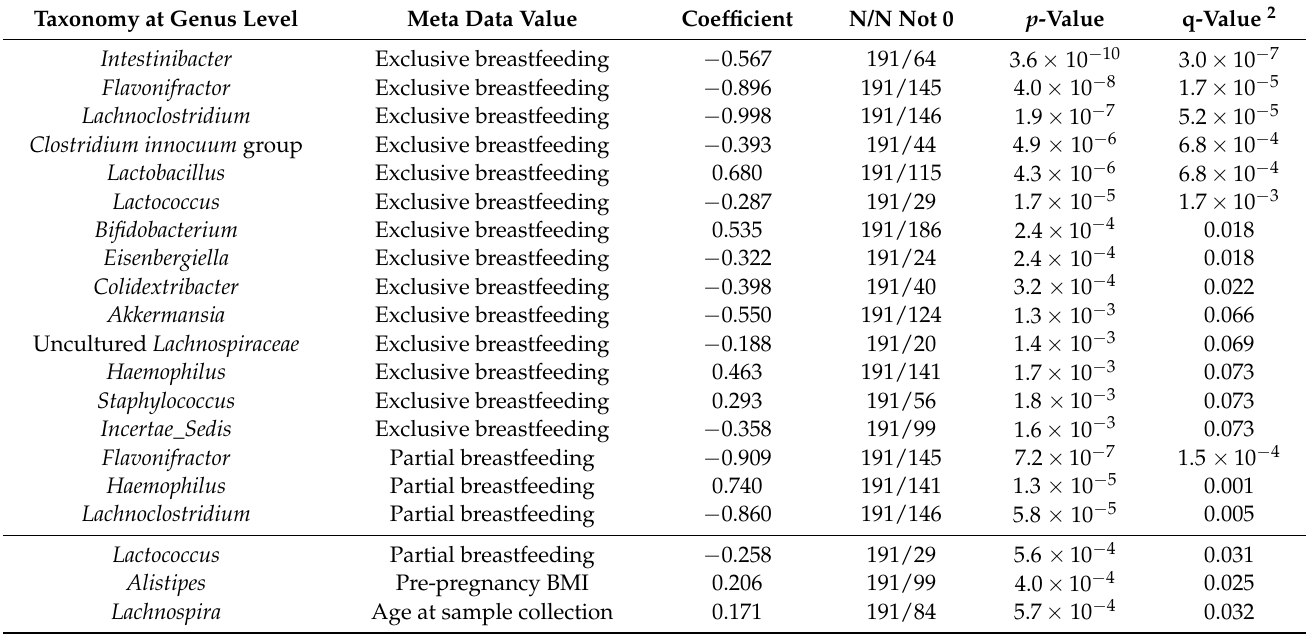
Table 4. MaAsLin Analysis Results: Associations of infant feeding practices and gut microbiome taxa at genus level adjusted by covariates in all infants (N = 191) 1 .